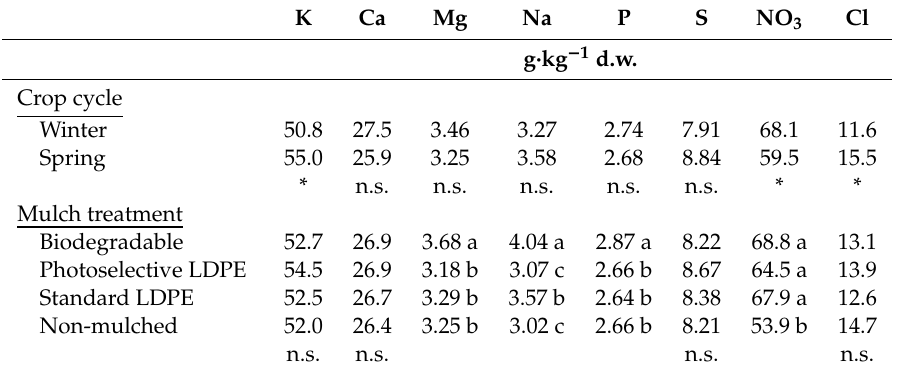
Table 4. Mean values of mineral composition of perennial wall rocket leaves as a ff ected by crop cycle and mulch